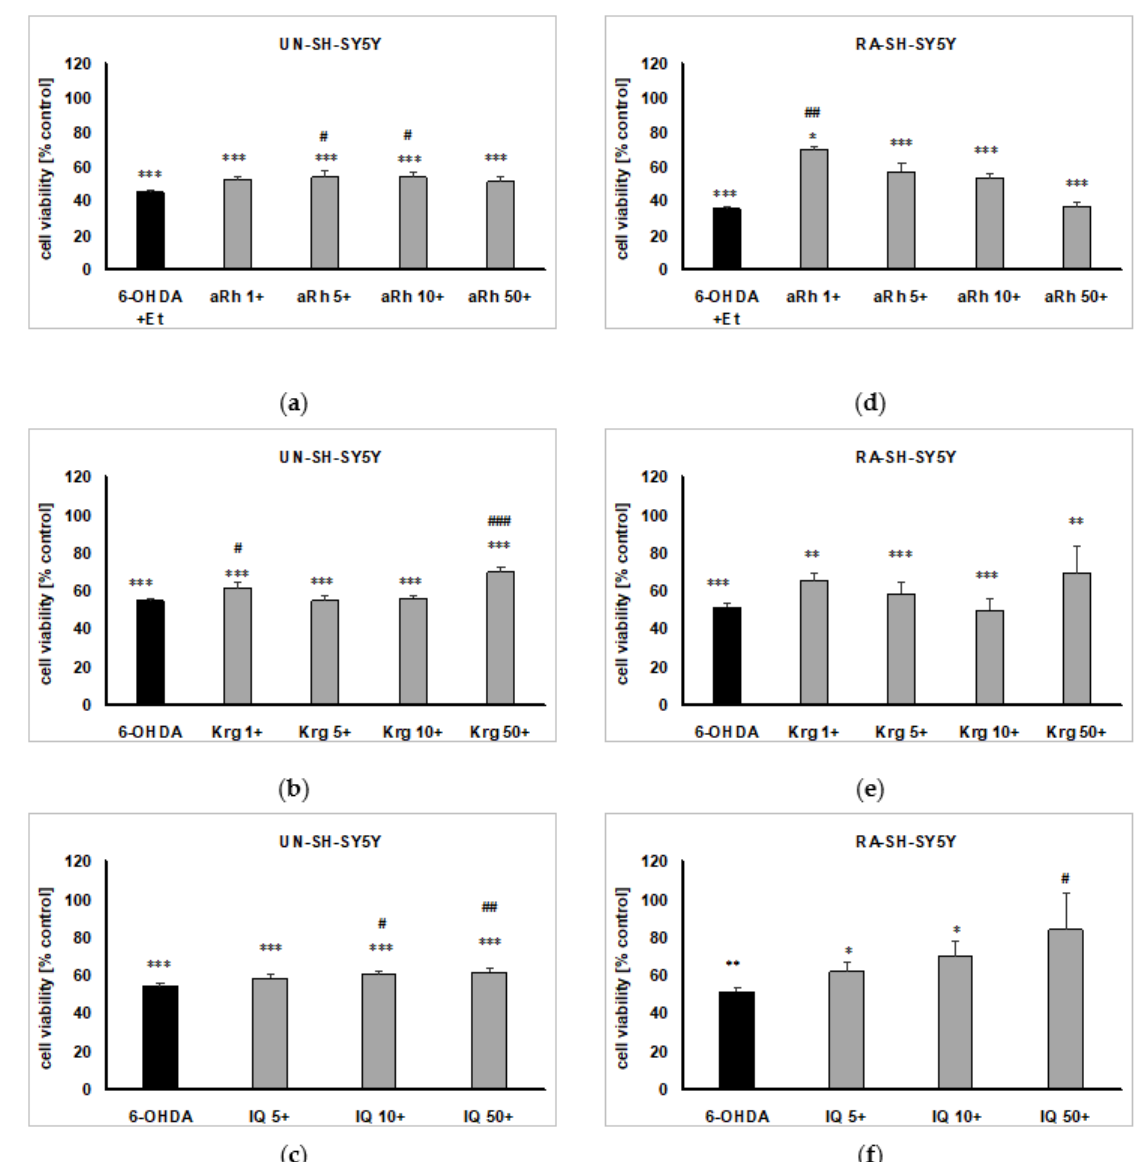
Figure 8. The protective effects of the tested flavonols against 6-hydroxydopamine (6-OHDA)-evoked cell damage in UN- ( a – c ) and RA-SH-SY5Y ( d – f ) cells. The cells were pre-treated for 30 min with α-rhamnoisorobin (aRh, 1–50 µM; a , d ), kaempferitrin (Krg, 1–50 µM; b and e ) and isoquercitrin (IQ, 5–50 µM; c , f ) followed by 24 h exposure to 6-OHDA (100 and 200 µM for UN- and RA-SH-SY5Y, respectively). The cell viability was measured by WST-1 assay and the data were normalized to the vehicle-treated cells and are presented as the mean ± SEM. The data were analyzed by one-way ANOVA. * p < 0.05, ** p < 0.01, *** p < 0.001 vs. the vehicle-treated cells; # p < 0.05, ## p < 0.01 and ### p < 0.001 vs. the 6-OHDA-treated cells.